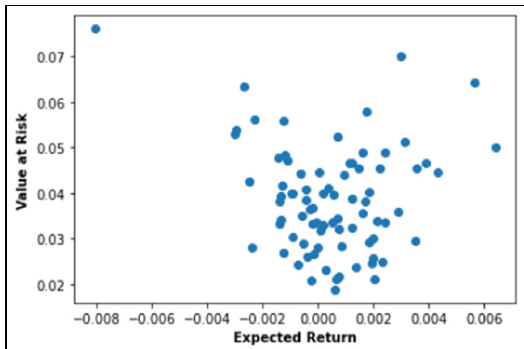
Fig. 2. Scatter Plot of IDX80